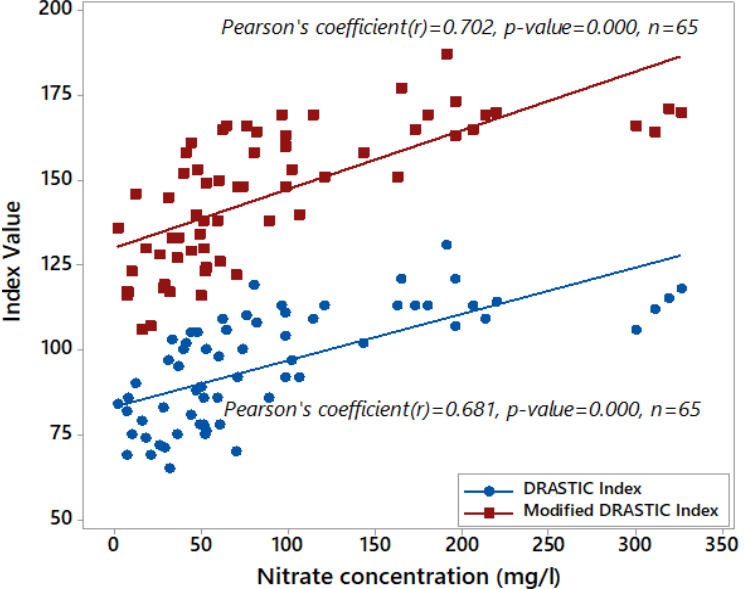
Figure 8. Index values plotted against nitrate concentrations to examine the correlations. A significant ( p -value = 0.000) correlation with a moderate and positive Pearson’s correlation (r) was observed for the study area in both the DRASTIC and modified DRASTIC approaches (0.681 and 0.702, respectively) for the nitrate concentration ( n = 65).